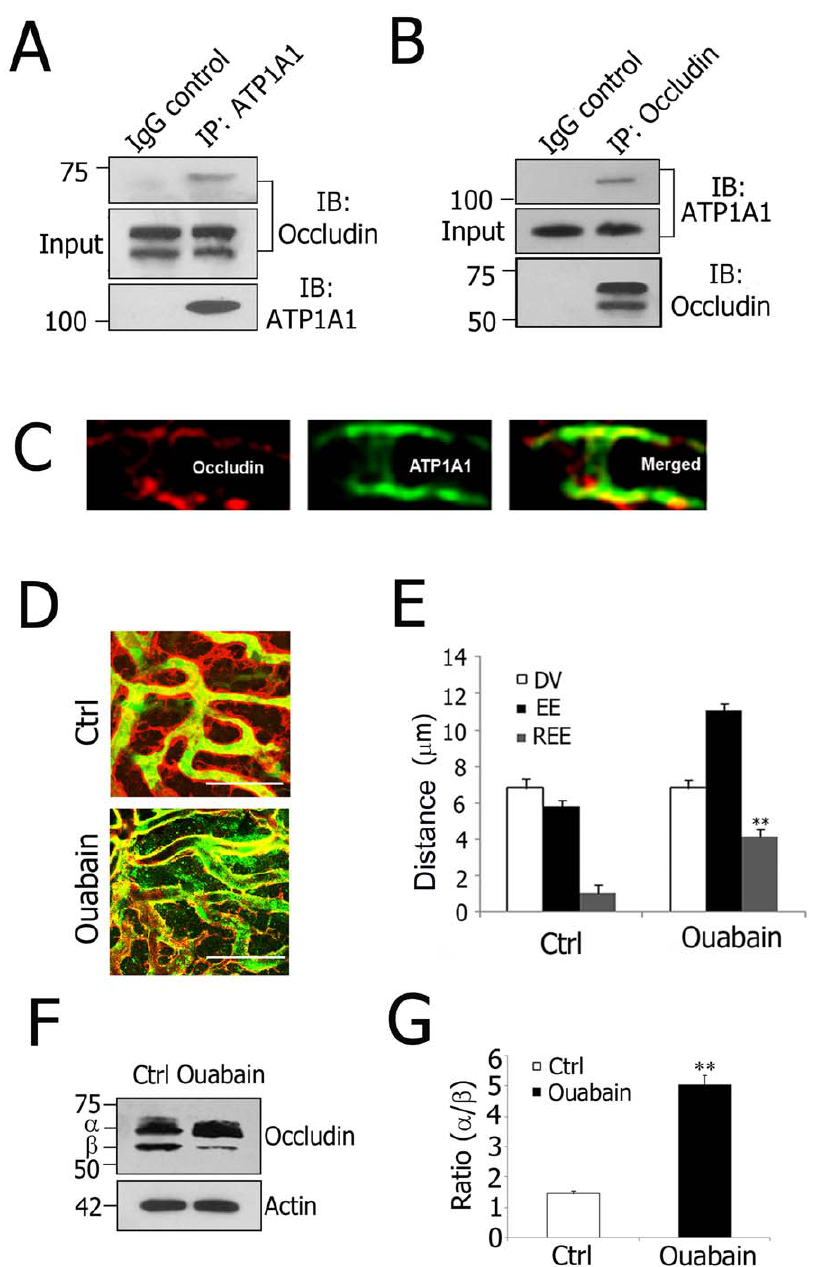
Figure 4. ATP1A1 regulation of TJ permeability involves occludin phosphorylation in the blood-labyrinth barrier. A and B , Co- immunoprecipitation using isolated stria vascularis capillary lysates demonstrates that ATP1A1 is in a complex with occludin. Preimmune goat IgG served as a negative control. C , Immunolabeling of stria vascularis capillaries for occludin (Left, red) and ATP1A1 (Middle, green). The merged image (Right) shows that occludin and ATP1A1 co-localization. D , Confocal images show increased TJ permeability in ouabain-treated tissues (Lower) compared to control tissues (Upper). Serum protein IgG (green, antibody for IgG (H + L) is outside the lumen of the capillary (red, antibody for collagen type IV). E , REE analysis confirmed the significantly increased permeability of ouabain-treated tissues (**P=0.005 , 0.01). F , Immunoblot analysis shows occludin migrates as two bands, hyperphosphorylated a ( , 70 kD) and dephosphorylated b ( , 65 kD), in both control and ouabain-treated tissues. G , The ratio of a band to b band in ouabain-treated tissues was significantly increased (**P=0.007 , 0.01). Values in E and G are mean 6 SEM (n=10). (Scale bars: D , 20 m m). REE: relative extension of serum protein IgG extravasation; DV: diameter of the vessels; EE: extension of IgG extravasation. doi:10.1371/journal.pone.0016547.g004 whether decreased Na + /K + -ATPase activity, and corollary TJ were elevated as assessed by auditory brain-stem response (ABR) (Figure S4). Immediately after noise exposure, blood-labyrinth reorganization, can account for noise-induced vascular leakage, animals were exposed to wide-band noise at 120 dB SPL for 3 h a barrier permeability was visualized with an REE of the serum day for 2 consecutive days. Hearing thresholds at all test frequencies protein IgG. Confocal imaging showed widespread blood-labyrinth